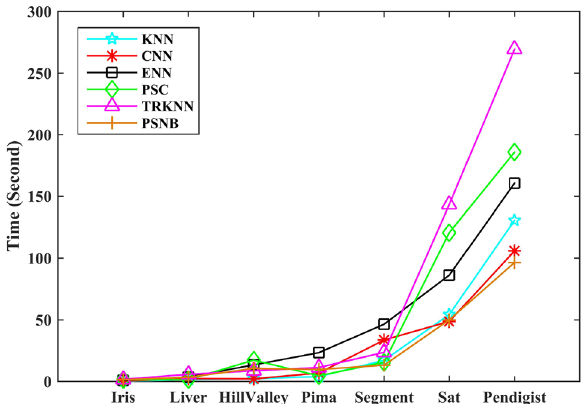
Figure 7. Running time of stationary experiments.